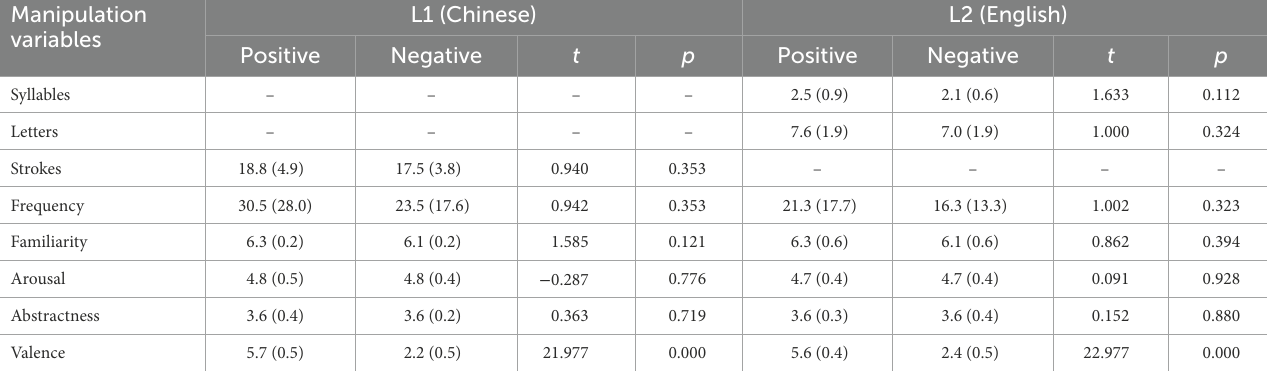
TABLE 4 Means and SDs of stimulus attributes for Chinese and English positive and negative emotional words. Manipulation